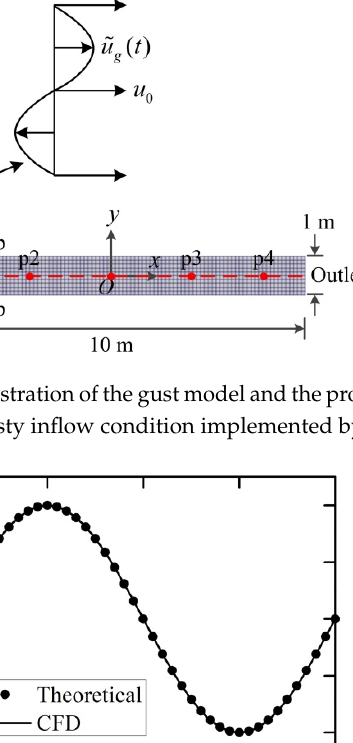
Figure 13. ( a ) The unsteady fluctuation and ( b ) the spectrum of the total pressure distortion at the AIP.